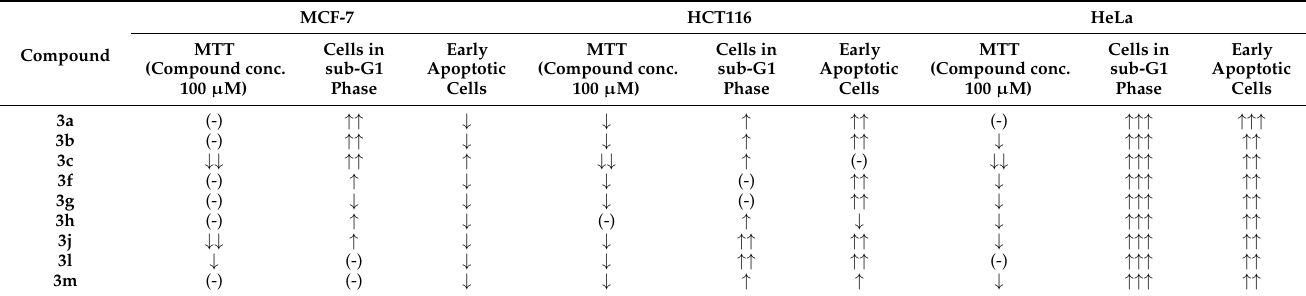
(-);(-);(-) — no effect. ↓ — decrease in SF value. The number of arrows indicates the strength of the effect (single weak, double stronger). ↑ — increase in the number of cells in sub-G1 phase compared to cells in the control group ↓ —a decrease in the number of cells in sub-G1 phase compared to cells in the control group. The number of arrows indicates the strength of the effect (single: weak, double: stronger, triple: the strongest). ↑ — increase in the number of early apoptotic cells compared to cells in the control group ↓ —a decrease in the number of early apoptotic cells compared to cells in the control group. The number of arrows indicates the strength of the effect (single: weak, double: stronger, triple: the strongest).